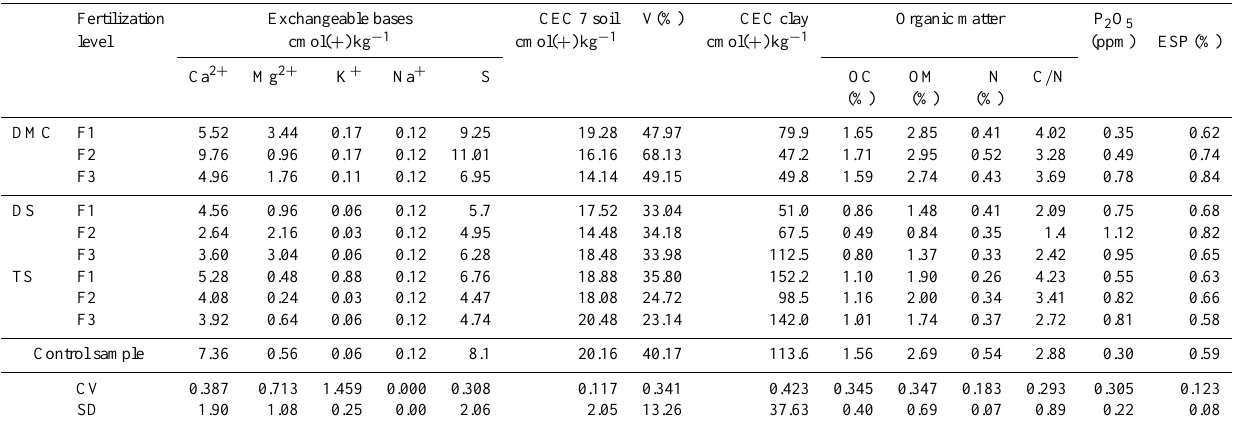
Table 4. Chemical properties of the studied soils.